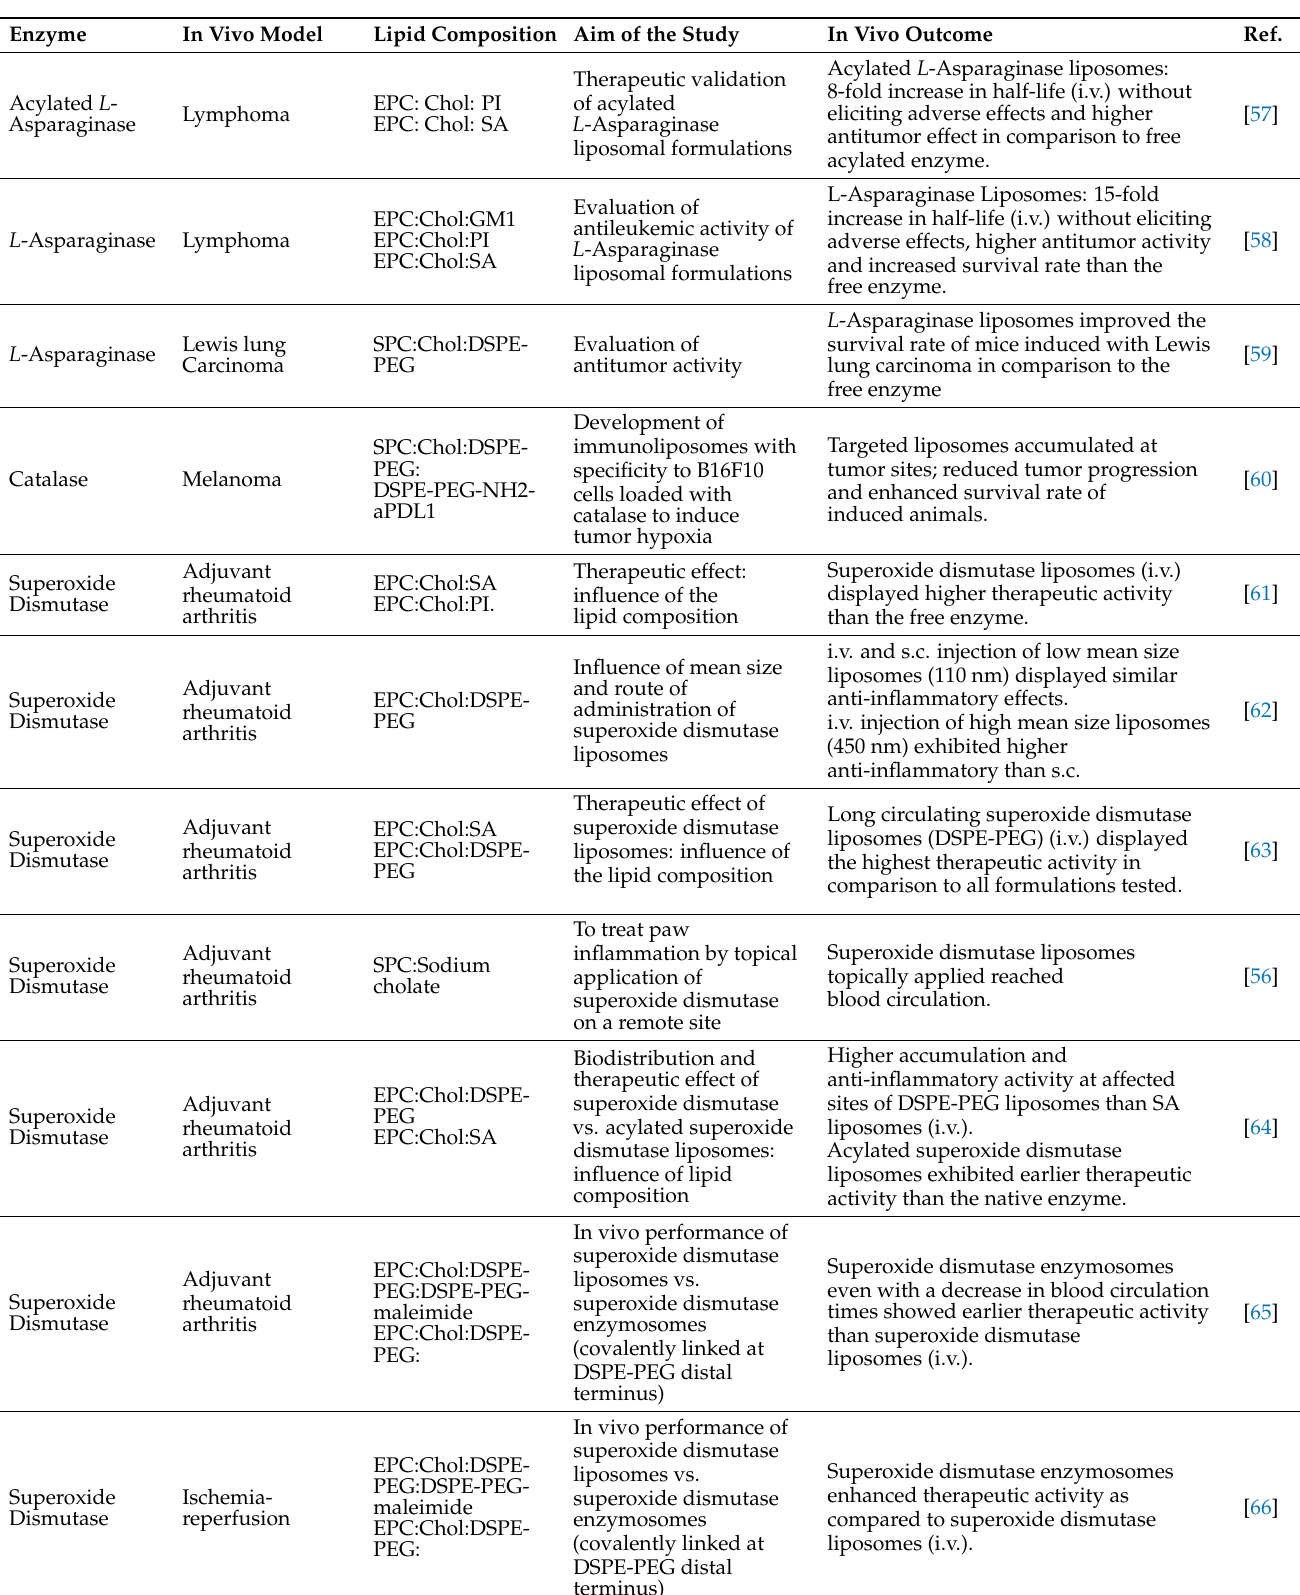
Table 3. Selected pre-clinical studies using enzymatic liposomal formulations.